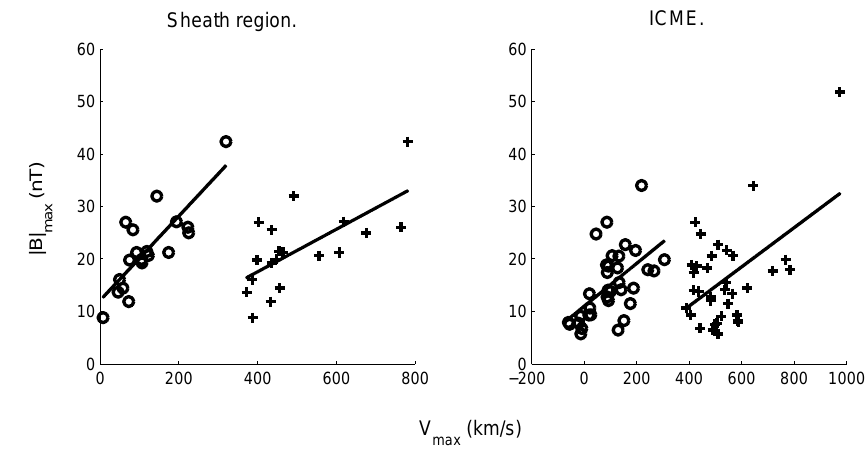
Fig. 7. The relationship between V max and | B | max , ( V max - V sw ) and ( | B | max ) shown as “o”s (“+”s) for the sheath region and ICME body.